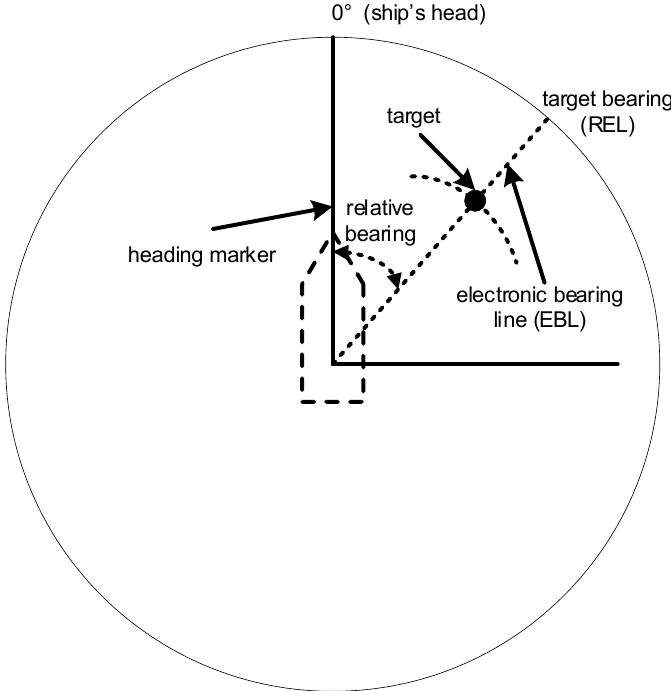
Figure 1. Measurement of relative